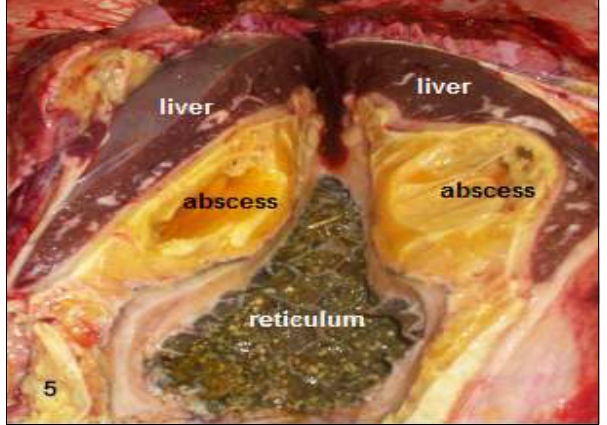
Figure-5: Post mortem finding of a buffalo shows a cut section in abscess with yellow capsule between liver and reticulum (cut section)